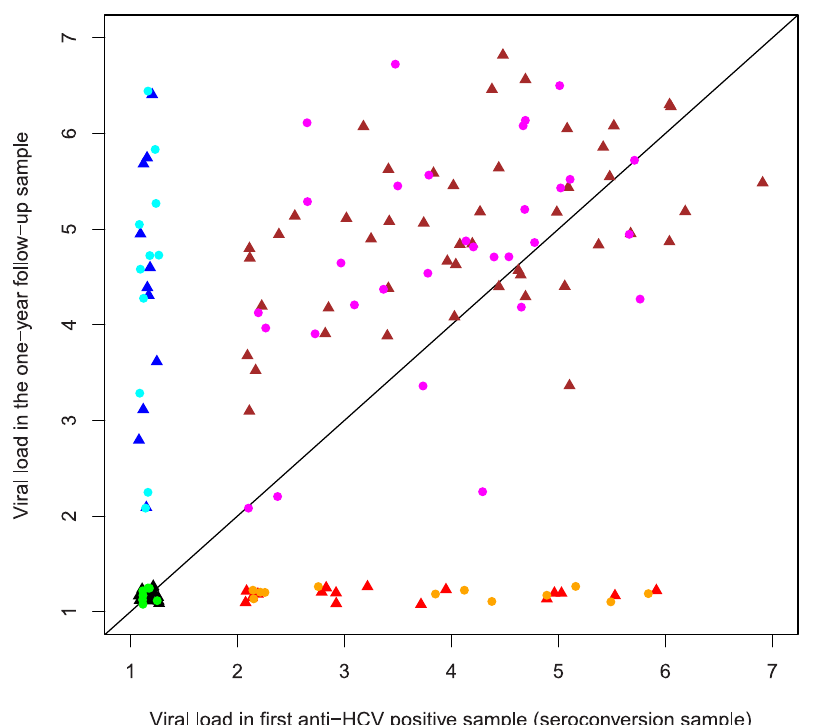
Figure 4. Pairwise comparison of individual viral loads in the seroconversion versus one year follow-up samples. Methodology as in figure 2 and 3. Viral load was significantly lower or equal to in the seroconversion sample compared to the one year follow-up sample for the whole cohort(p , 0.001, CI 0.63–0.78), as well as in the subgroup of pre-seroconversion viremic (n=61, p=0.002, CI 0.57–0.81). Excluding group G the values for the whole cohort were similar (p , 0.001, CI 0.60–0.76), but became less significant for the pre-seroconversion viremic subgroup p=0.065, CI 0.49– 0.77.